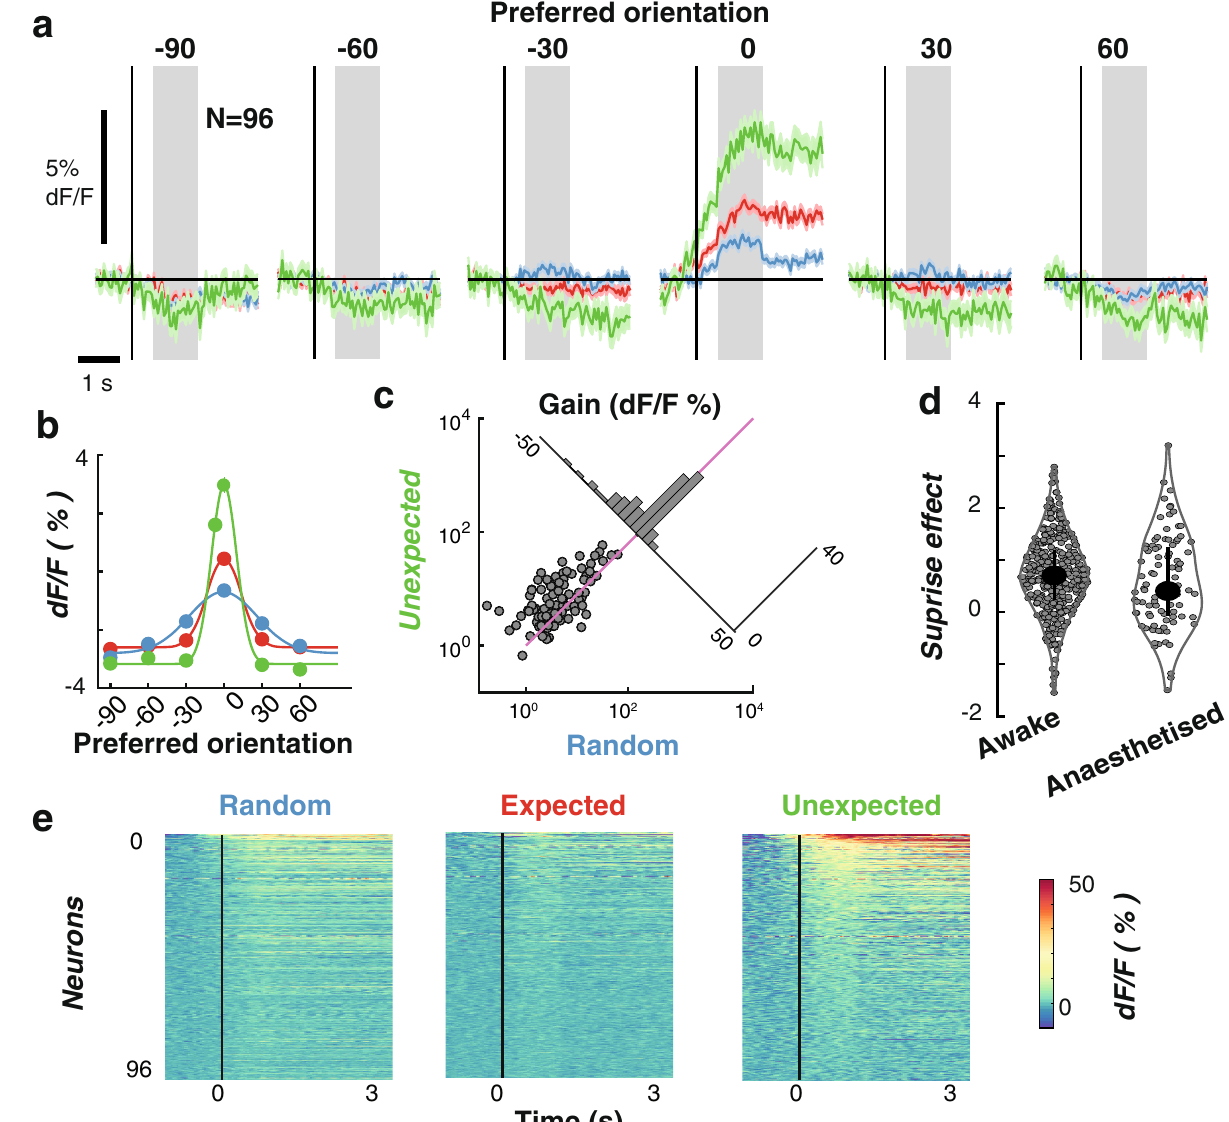
Fig. 6 | Expectations affect the gain of orientation-selective V1 neurons under anaesthesia ( N =96). a Time courses for all orientation-selective neurons aligned to their preferred orientation to allow averaging. Shading indicates ±1 standard error of the mean across neurons. b Population orientation tuning for the three expectation conditions, averaged across an epoch from 250 to 1000ms after sti- muluspresentation.Solid linesare fi ttedGaussianfunctionswithaconstantoffset. c Summary statistics for the gain of the fi tted Gaussians in b . The insert shows the distribution of the difference in response (Random minus Unexpected) for each